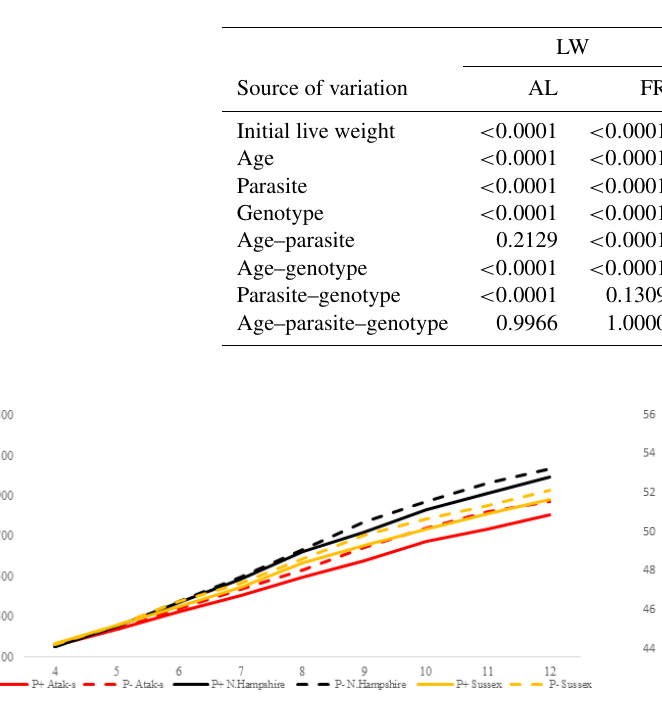
Table 2. Significance levels of variation sources for weekly live weights (LWs, g), feed conversion ratios (FCRs) separated by ad libitum and feed-restricted birds, and daily feed intake (DFI) per bird for birds fed ad libitum.